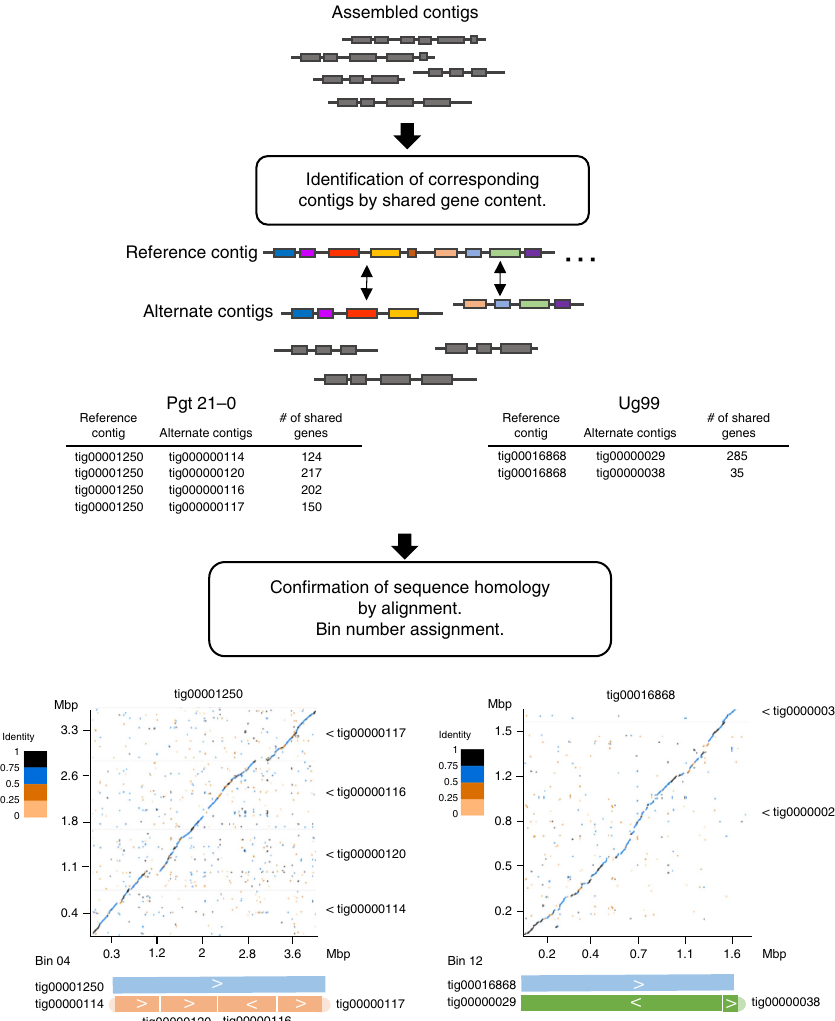
Fig. 1 Strategy to identify homologous contigs in genome assemblies by gene synteny. To detect shared content, Pgt gene models 21 (grey and coloured boxes) were aligned to the genome assemblies and the contig positions of the top two hits of each gene were recorded. Contigs containing at least fi ve shared genes were considered as potential haplotype pairs. Sequence collinearity between contigs was assessed by alignment, and homologous matching contigs were assigned to bins. Examples shown are for Bin04 and Bin12 from Pgt 21-0 and Ug99,